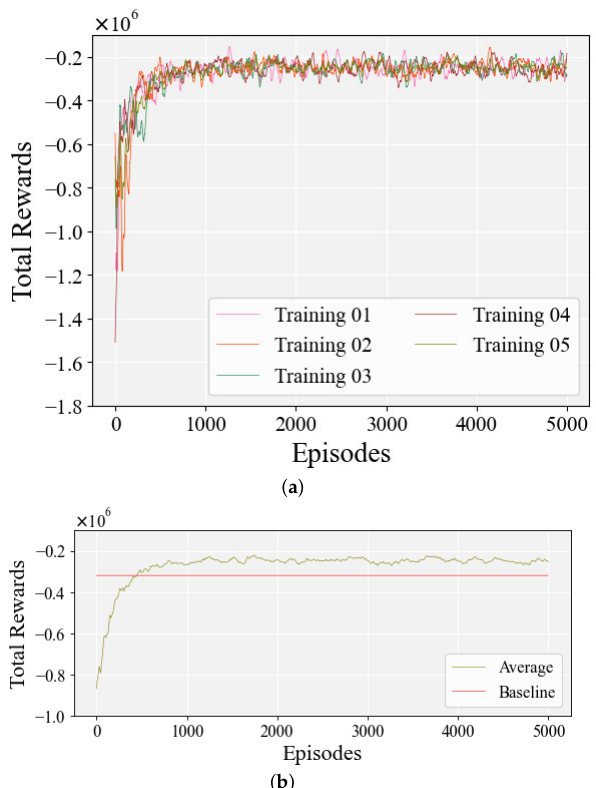
Figure 15. The learning process of KA-DDPG without the guiding reward method: ( a ) total rewards for each learning process and ( b ) the average value of the total